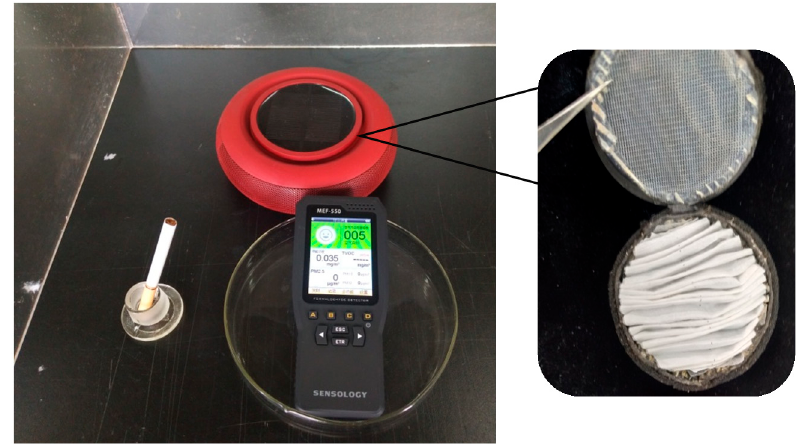
Figure 8. Apparatus of the air purification experiment, including car air purifier, air quality detector and cigarette. Enlarged figure on the right shows the filter in the car air purifier made of fibrous membranes.